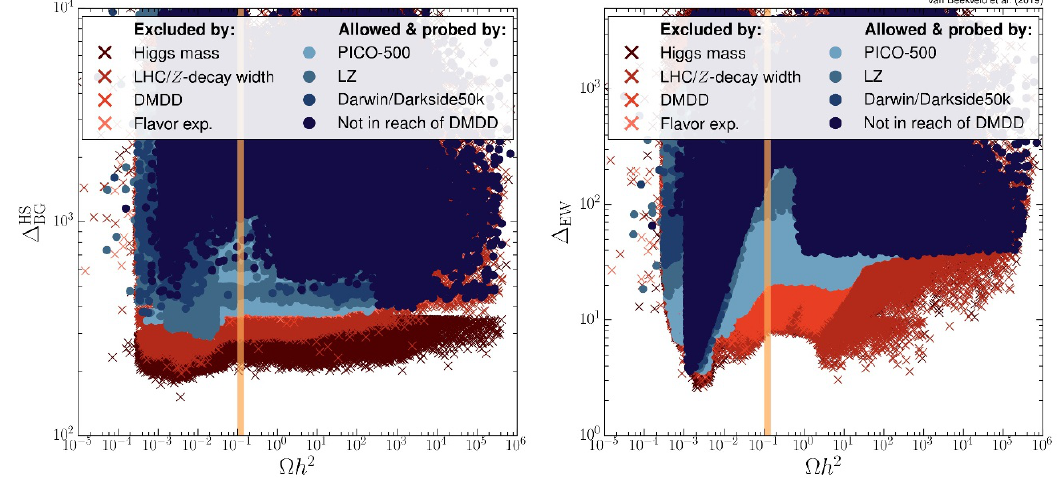
Figure 8 . Generated spectra for the NUHGM model. The left (cid:12)gure shows (cid:1) HS (cid:10) h 2 , the right (cid:12)gure shows (cid:1) EW as a function of (cid:10) h 2 . The color code and plotting order is the same as in (cid:12)gure 1. The orange band indicates (cid:10) h 2 = 0 : 12.